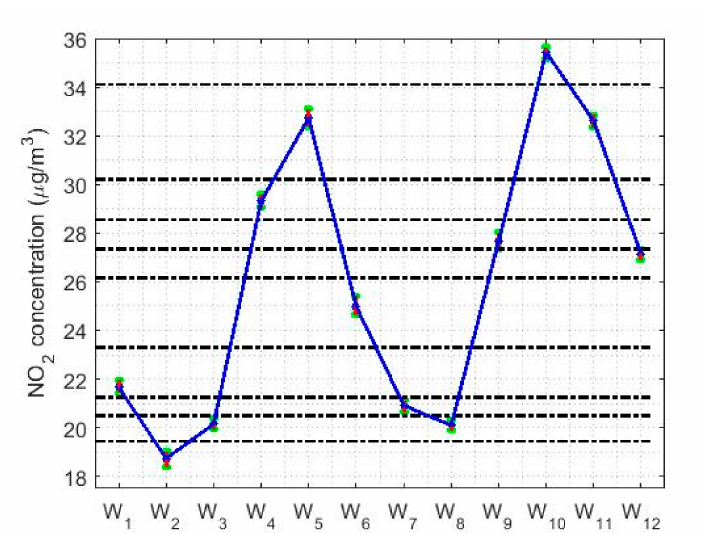
Figure 14. 95% nonparametric confidence intervals for the medians: W 1 (0:00–1:00), W 2